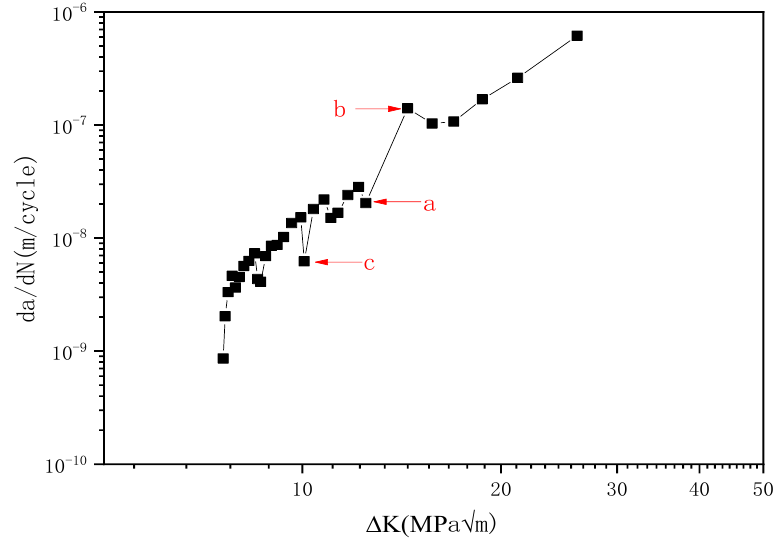
Figure 16. Crack growth rate of specimens.